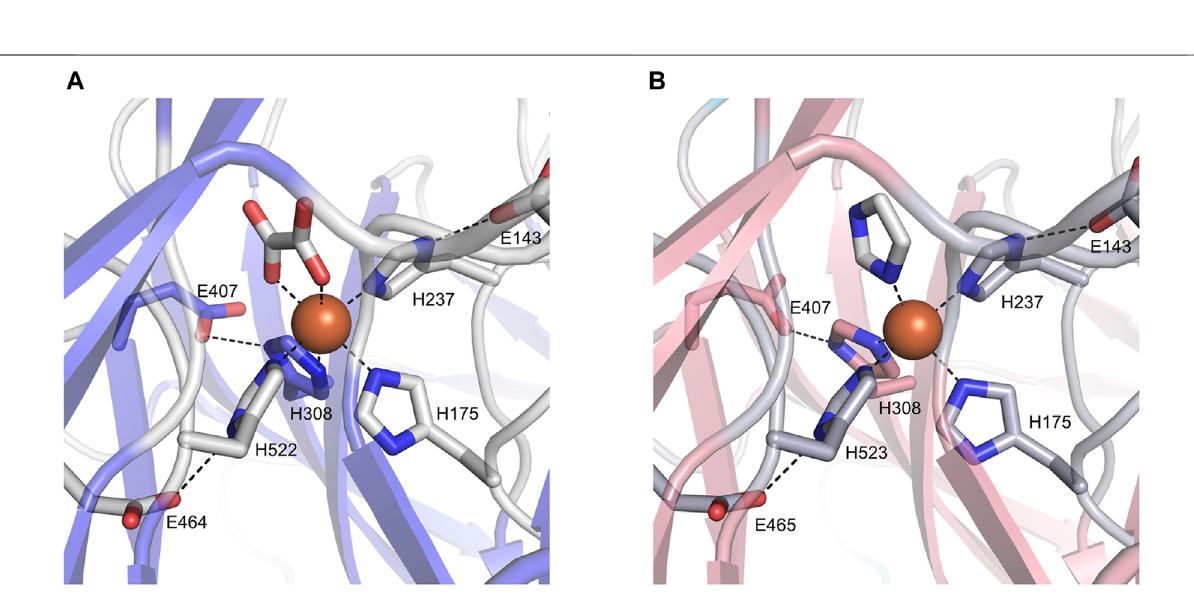
FIGURE 6 | The active centers. (A) BCMO-1 active center. Ribbons are in transparence; ligands and the side chains of residues constituting the iron center are shown as sticks; dashed lines denote metal coordination and the hydrogen bonds of Glu143, Glu407, and Glu464/465 with His237, His308 and His522/523, respectively. (B) BCMO-2 active